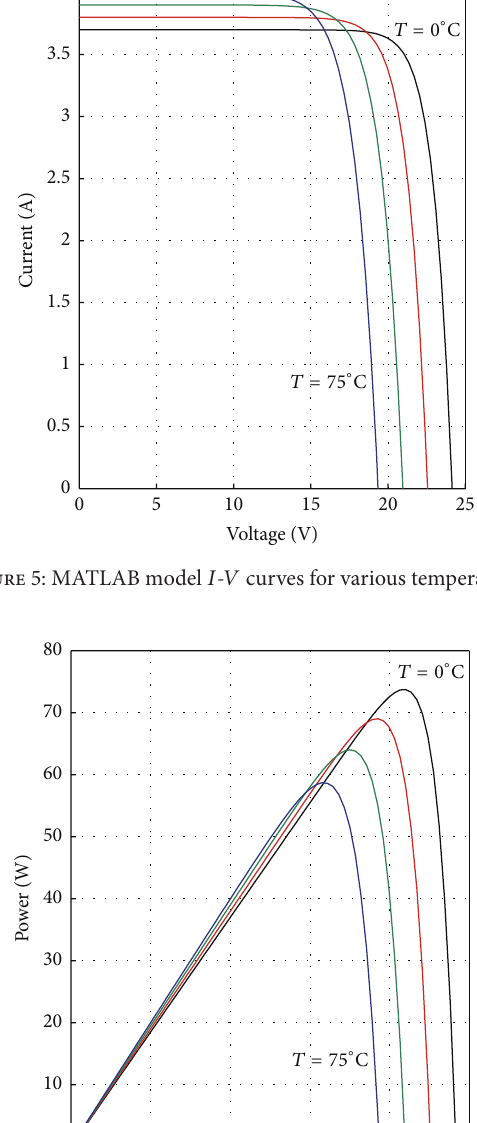
Table 3: Catalogue data of solar panel.